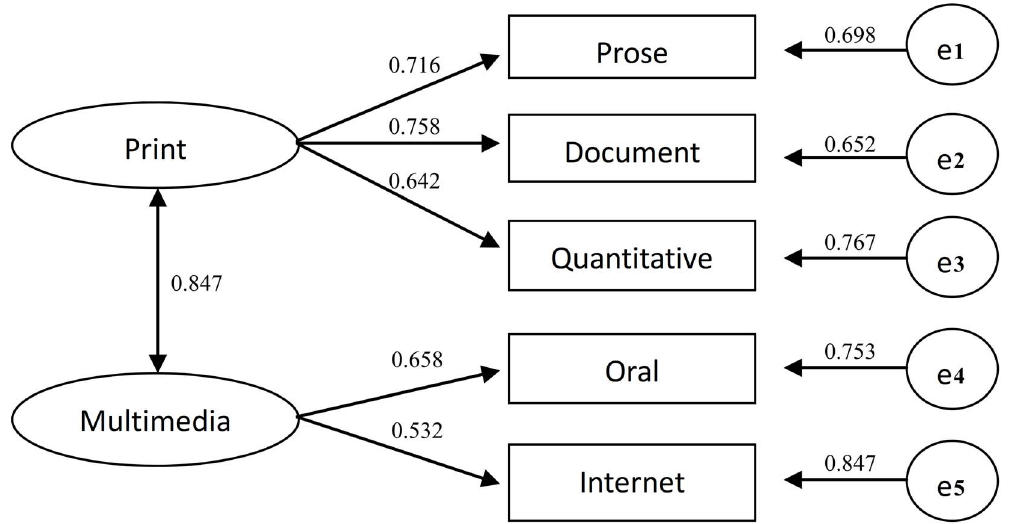
Figure 1. Confirmatory factor analysis of the instrument of health literacy by Covariance Structure Analysis with standard coefficients. Note: ‘‘e1’’ to ‘‘e5’’ were the residuals of